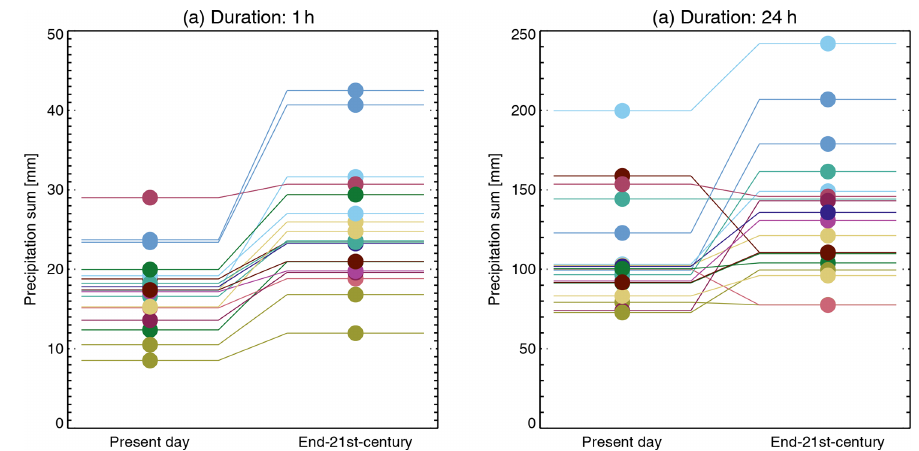
Figure 4. Modelled return levels at 50 ◦ N, 10 ◦ E (northern Germany; marked with a red cross in Fig. 1) for the present and future for a 10-year return period and 1 and 24h durations. Different colours represent the 19 different GCM–RCM simulations listed in Table 1.